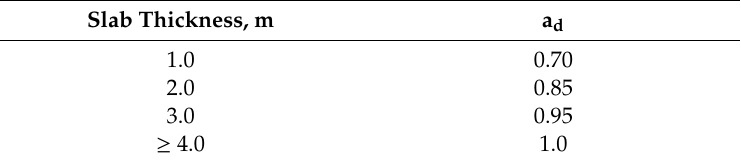
Table 4. Reduction coe ffi cients a d